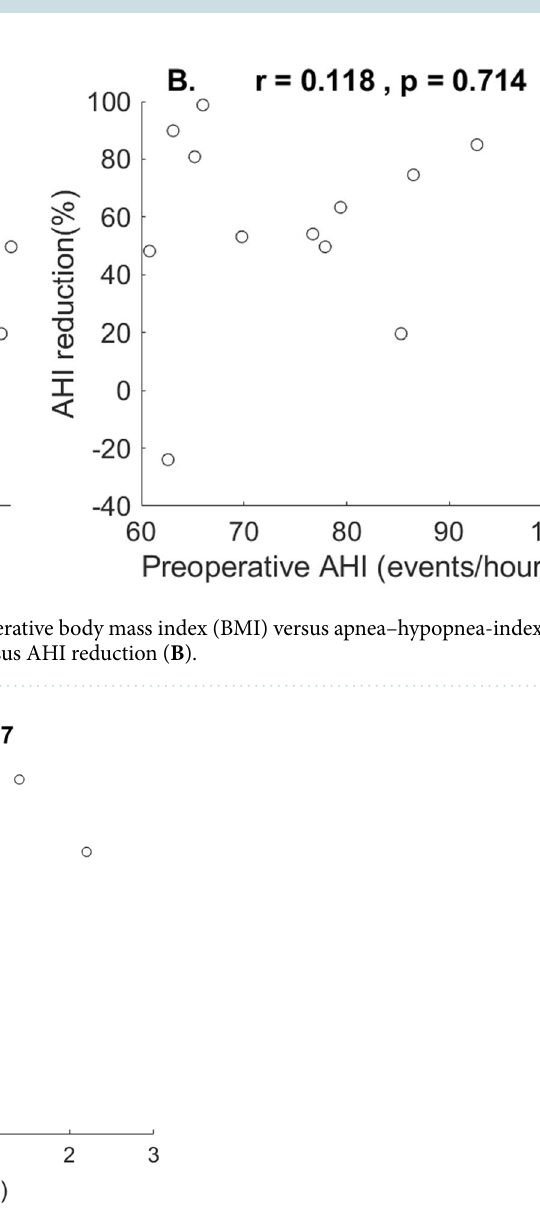
Figure 7. Scatterplot showed a trend of losing weight after the surgery but no statistic correlation between body-mass-index (BMI) change and apnea–hypopnea-index (AHI)